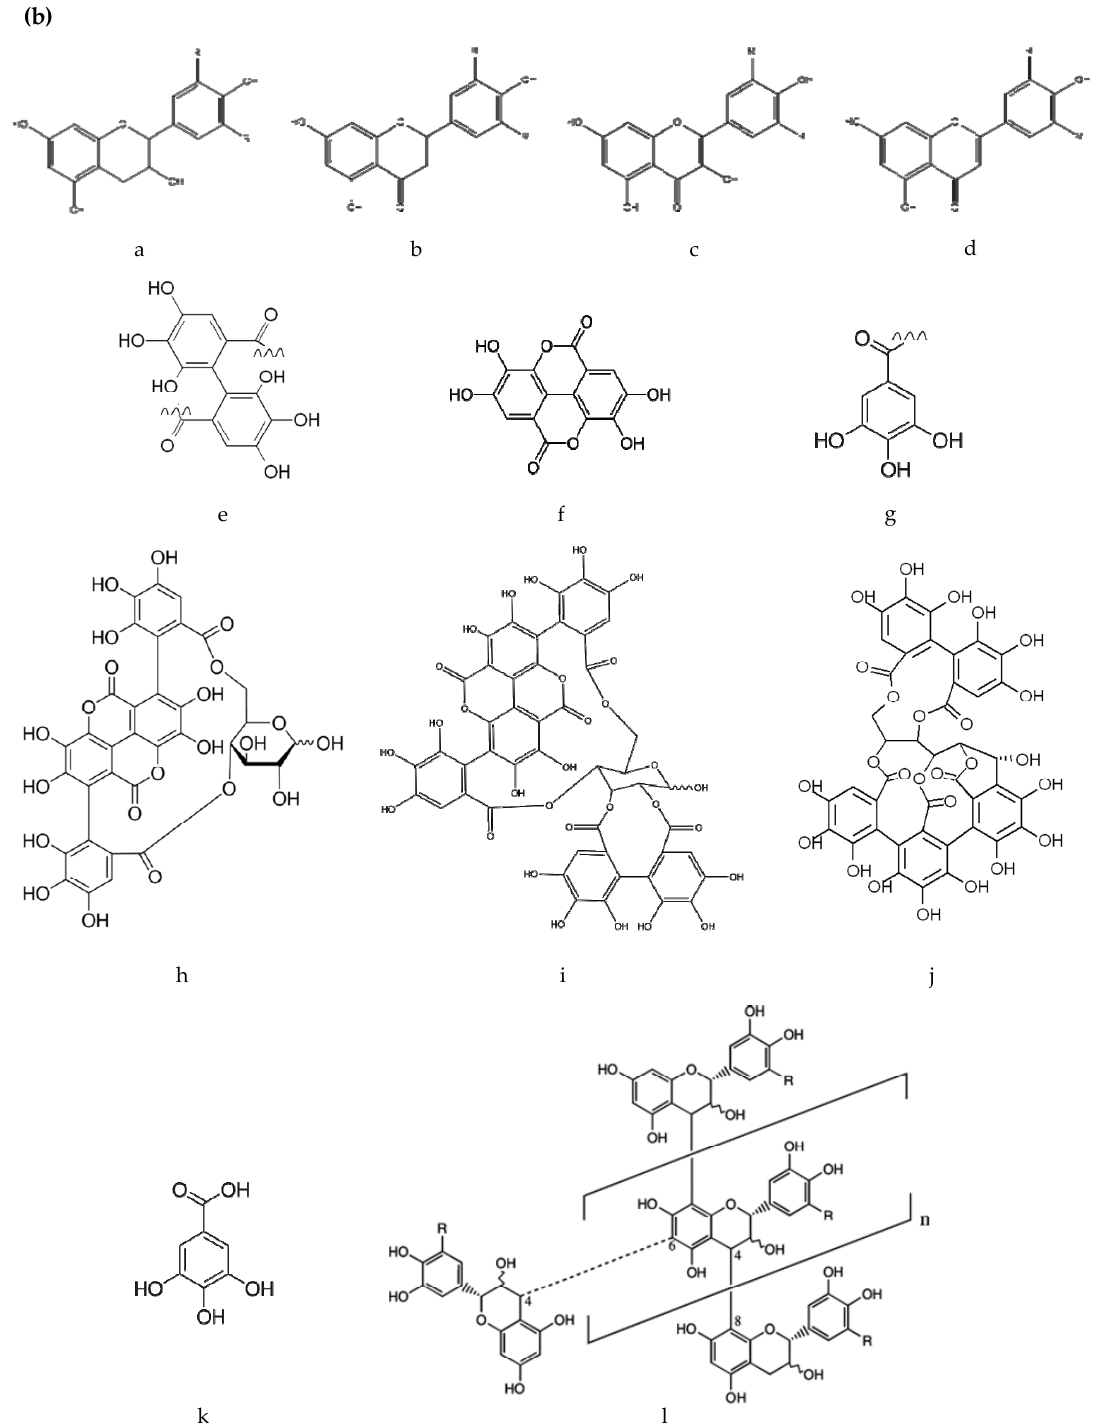
Figure 1. ( a ) Changes of individual compounds identified by RP-HPLC-DAD analysis. Concentrations of individual identified compounds are expressed as milligram per 10 grams of plant dry weight. Means ( n = 3), showed as blank dots in each sub-figure, followed by different lowercase letters that report significant differences ( p < 0.05) of phenolic concentrations during 0–24 h storage, according to Tukey’s test. ( b ) Structures of polyphenolic compounds present in the pomegranate leaf infusions. a: flavan-3-ols; b: flavanone; c: flavonol; and d: flavone. Basic structures of ellagitannins, such as e: HHDP acid, f: ellagic acid, g: galloyl group; h: punicalin; i: punicalagin; j: other possible ellagitannin (e.g., castalagin); k: gallic acid; and l: condensed tannin.